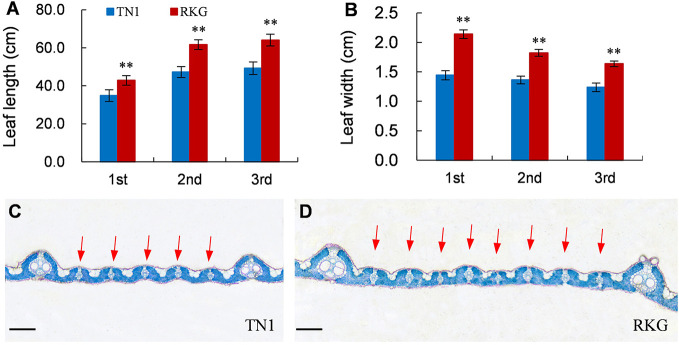
Leaf traits of TN1 and RKG. (A, B) Leaf length and width of top-three leaf (n=10). ** indicates a significant difference (P < 0.01) by student’s t-test. (C, D) Paraffin cross-section of third leaves, the red arrow indicates the small vein, Scale bar = 20μm.